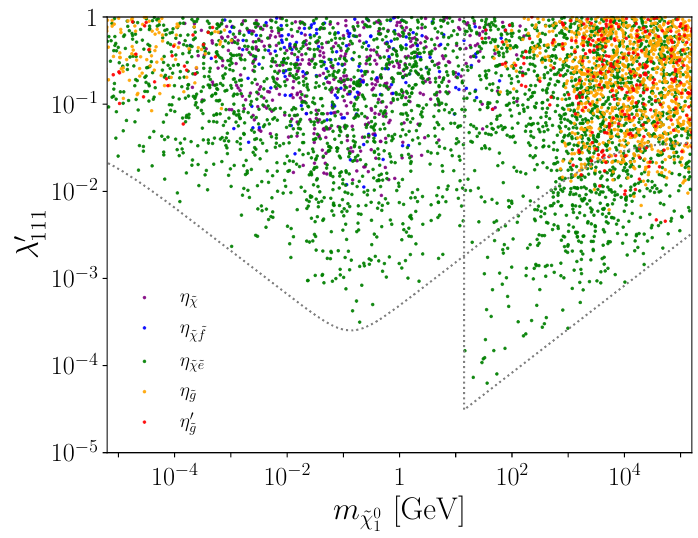
Figure 4 . Randomly generated points in the ( λ 0 observation of 0 νββ decay in 76 Ge by GERDA, T exp dominates in eq. (4.4) or (4.5). The two dashed lines indicate the values of ( λ 0 the current experimental lower limit on T 0 ν